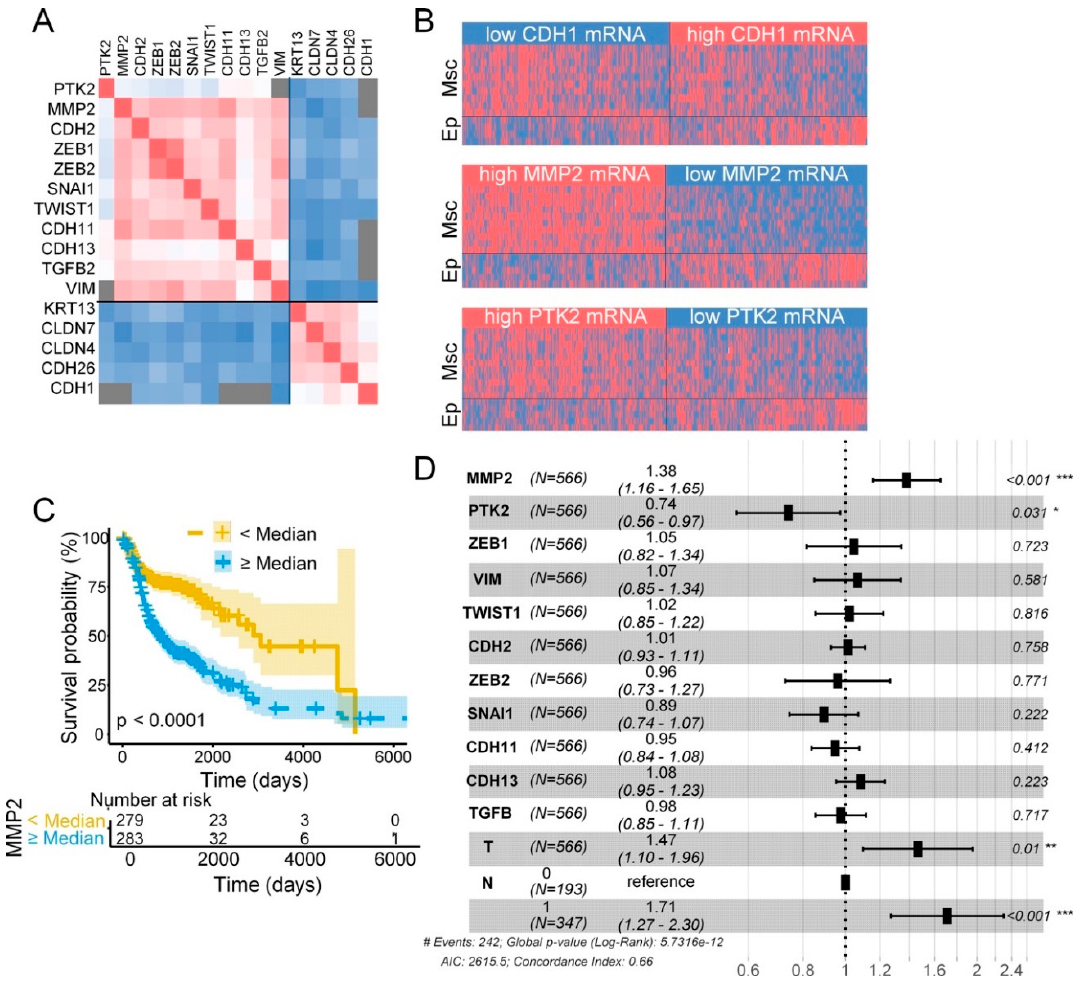
Figure 10. High MMP2 mRNA levels are significantly associated with poor prognosis independently of EMT transcriptional signature or PTK2 mRNA levels. ( A ) A heatmap showing positive (red) and negative (blue) correlations of mRNA levels of PTK2 , MMP2 , and the indicated mesenchymal ( CDH2, ZEB1, ZEB2, SNAI1, TWIST1, CDH11, CDH13, TGFB2, VIM ) and epithelial ( KRT13, CLDN7, CLDN4, CDH28, CDH1 ) biomarkers in head and neck SCCs included in the TCGA dataset (n = 566 tumors). ( B ) Graphic representation of the epithelial/mesenchymal gene expression signature of head and neck SCC included in the TCGA dataset. Tumors were dichotomized into high (red) or low (blue) gene expressors taking into account whether the mRNA levels of MMP2, PTK2, CDH1 and the epithelial (Ep) genes, CLDN7, CLDN4, CDH26, KRT13 , or mesenchymal (Msc) genes, CDH2, ZEDB1, ZEB2, SNAI1, SNAI2, TWIST1, CDH11, CDH13, TGFB2 , and VIM , were, respectively, above or below the median value of mRNA levels of the corresponding gene. ( C ) Kaplan–Meier curves for head and neck SCC patients (TCGA database) according to the MMP2 mRNA levels (median value = 12.3). The 95% confidence intervals (shaded areas) are also represented; permutated log-rank p -value for the hypothesis testing of equality of curves between groups is also reported. ( D ) Forest plot of primary outcome indicating genes associated with prognosis in head and neck SCCs.